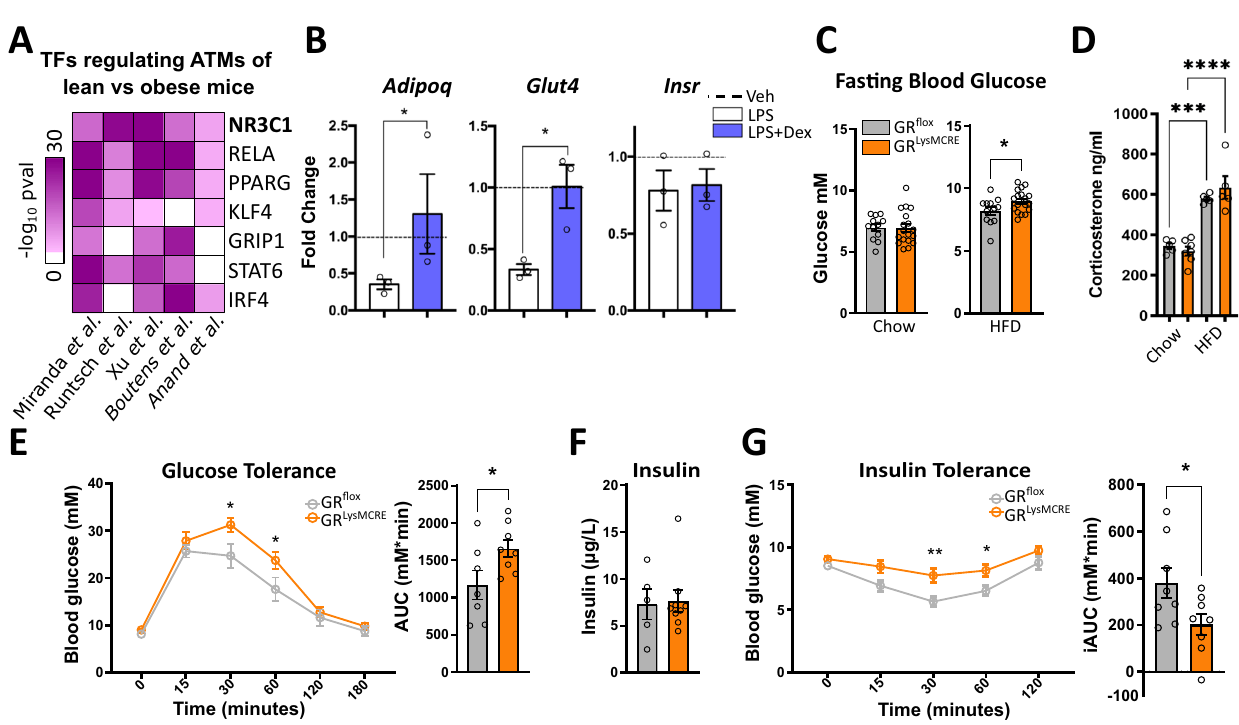
Fig. 1 | GR in macrophages protects against insulin resistance. A Differentially expressedgenes( padj <0.05)ofpublishedexpressiondatasetsfrommacrophages analyzed by LISA to predict regulatory transcription factors. B In vitro differ- entiated adipocytes from stromal vascular fraction (SVF) were co-cultured with bone marrow-derived macrophages (BMDMs) for 24h. Macrophages were pre- treated with vehicle, LPS (100ng/ml), or LPS+dex (100nM) for 24h, followed by washout before co-culturing. Adipocytes were separated via MACS and gene expressionwasquanti fi edbyqPCRrelativetovehiclecontrol(dottedline)( n =3, N describes macrophages from individual mice). C Blood glucose was analyzed before and after 29 weeks of a 60% high-fat diet (GR fl ox : n =12, GR LysMCre : n =18, N describesindividualmice). D CorticosteronelevelsweremeasuredbyMSfromlean and obese GR fl ox and GR LysMCre mice (GR fl ox : n =5, GR LysMCre(lean) : n =7, GR LysMCre(obese) :